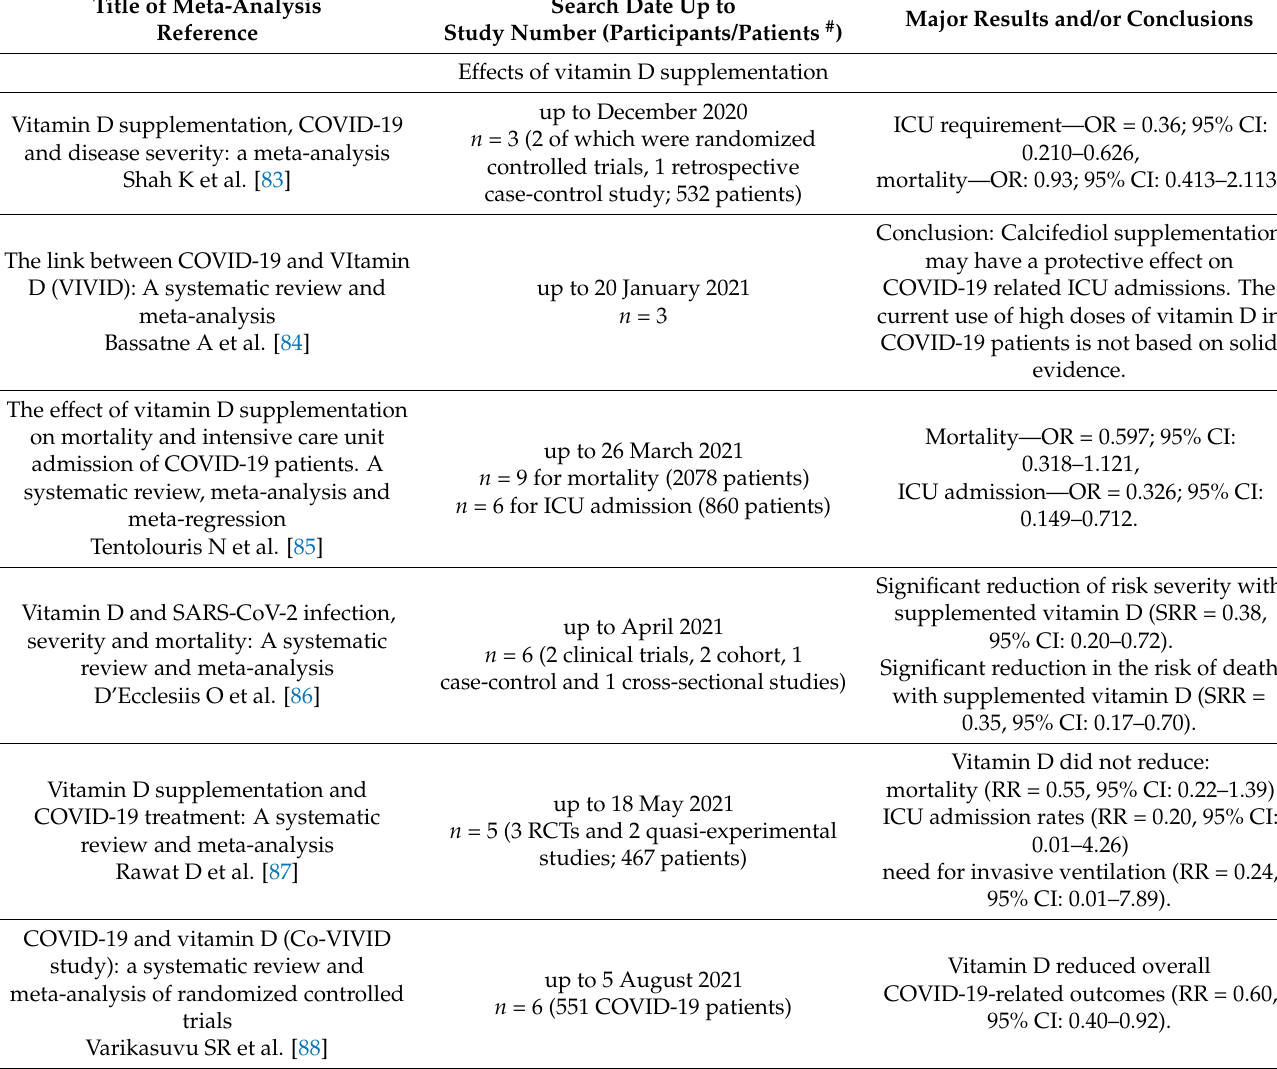
Table 1. Vitamin D and COVID-19: Brief summary of selected meta-analyses regarding vitamin D supplementation or vitamin D status and SARS-CoV-2 infection risk or clinical outcomes of COVID-19 in adults